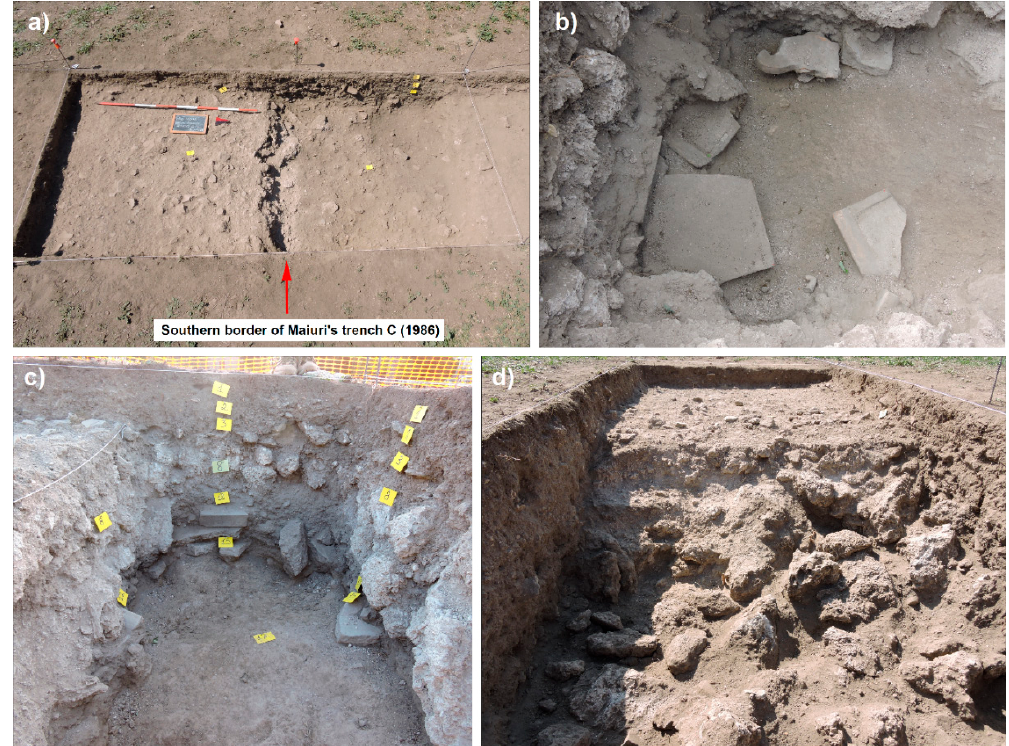
Figure 16. Photos of stratigraphical survey No. 242. ( a ) The southern border of Maiuri’s trench C (1986), which came to light only a few decimeters from the surface; ( b ) the cut of trench C and its subsequent backfill with travertine chips and blocks; ( c ) the stratigraphy of the east part of trench 242; ( d ) the beaten-earth floor strewn with remains of the collapsed roof.